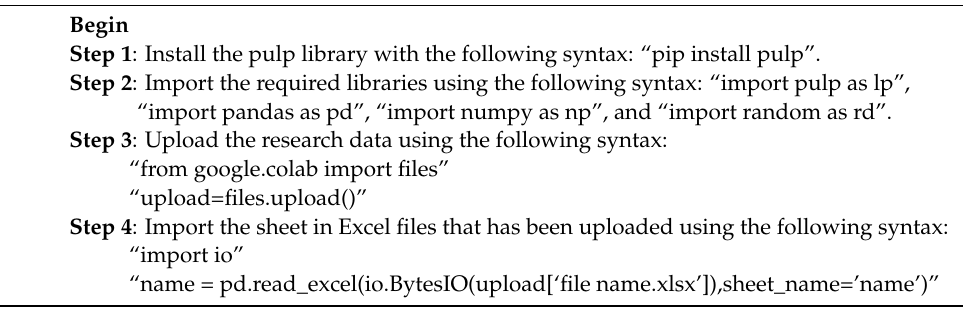
Algorithm 4: Library installation and data upload.